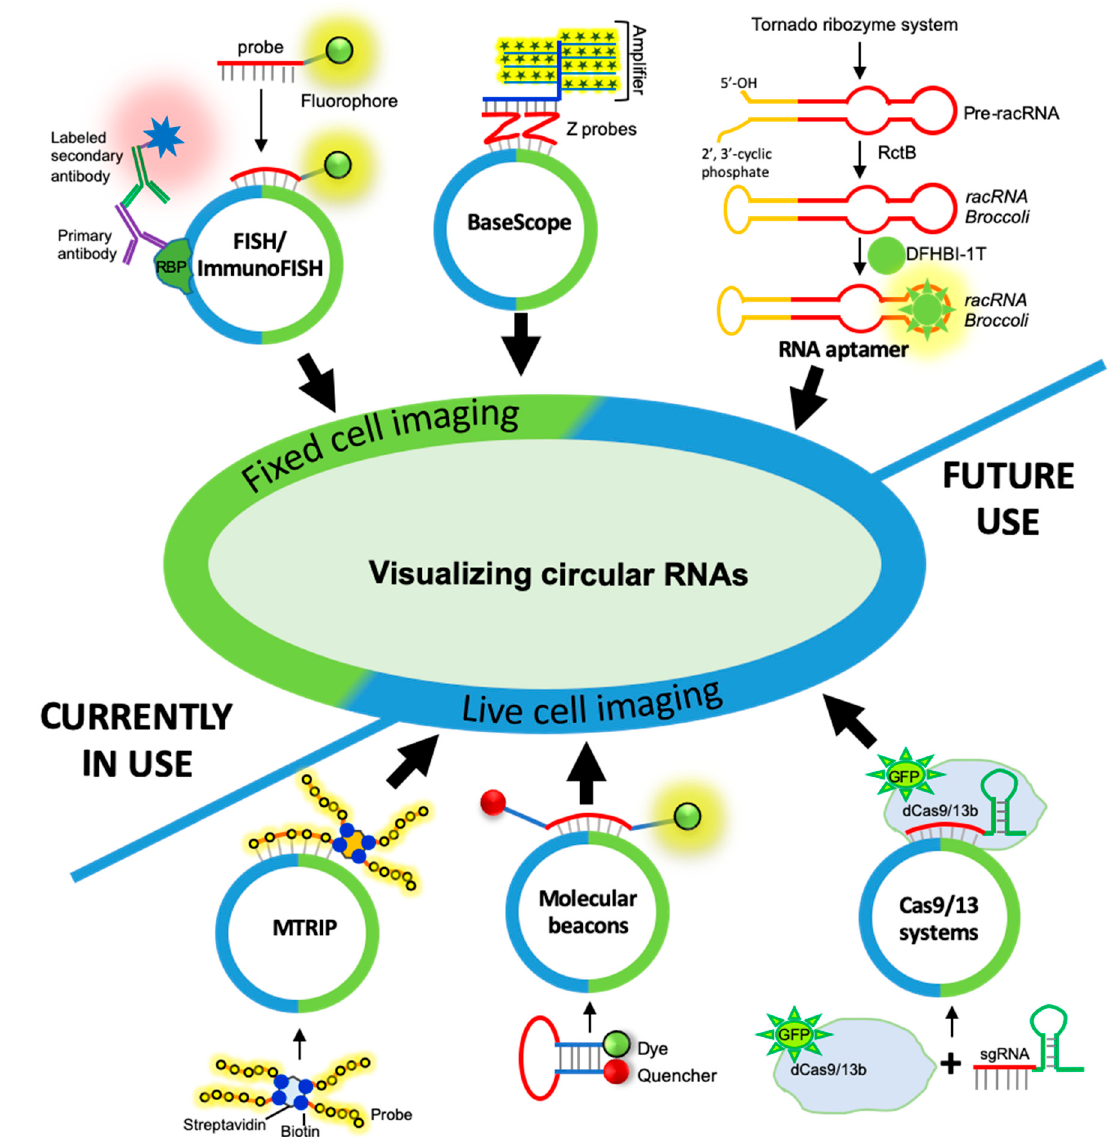
Figure 2. Schematic representation of different approaches for visualization of circular RNAs. (From top-left clockwise) circRNAs can be visualized in the fixed cells using single-molecule fluorescence in situ hybridization (smFISH) probes targeting the backsplice junction sequence. Additionally, proteins associated with the circRNA of interest can be co-detected using immunofluorescence assay while the circRNA can be detected with smFISH. CircRNAs may also be detected with the BaseScope Z pair probes targeting the backsplice junction, which are targeted by the pre-amplifier scaffold for fluorescent or chromogenic signal amplification. Fluorescent RNA aptamer sequences can be cloned into the circRNA sequence, which binds to the dye to emit fluorescence for live-cell visualization and tracking of circRNAs. The dCas imaging system requires the overexpression of GFP-tagged inactive Cas9/13b and sgRNA targeting the circRNA backsplice junction. The fully assembled dCas protein and sgRNA bound to target circRNA can be used for live-cell imaging of circRNAs. Molecular beacon probes targeting the circRNA junction sequence contain a fluorescent tag and a quencher. Upon binding to target circRNA in live cells, the dye dissociates from the quencher allowing visualization of target circRNA. The multiply labeled tetravalent RNA imaging probe (MTRIP) method uses internally labeled fluorescent probes targeting the circRNA junction, and the biotin tag at the end of the probe can tetramerize inside the cell with the streptavidin to amplify the signal for circRNA live-cell imaging. Table 1. List of circRNAs analyzed by imaging techniques.